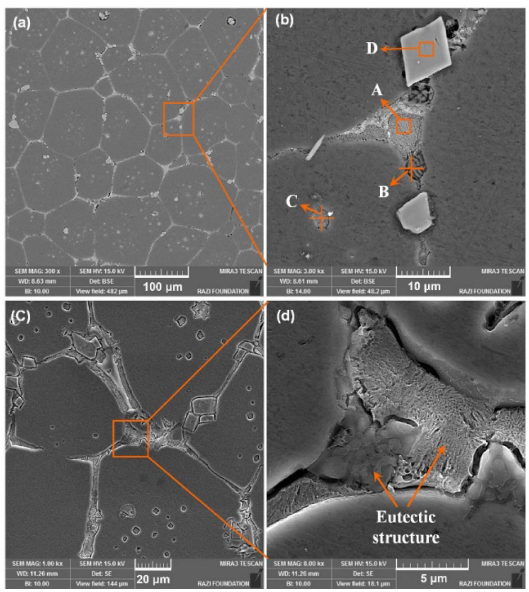
Figure 6. SEM electron images of the strained samples heat treated at ( a ) 600 ˝ C for 25 min; ( b ) 600 ˝ C for 25 min in higher magnification; ( c ) 610 ˝ C for 25 min; ( d ) 610 ˝ C for 25 min in higher